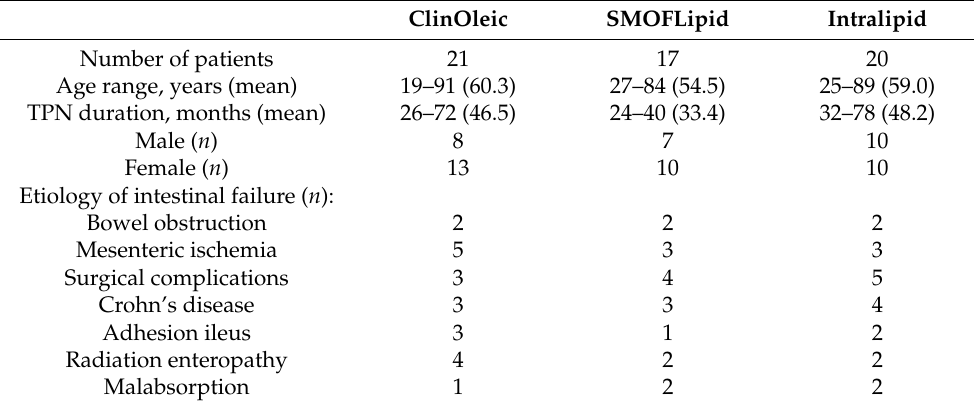
Table 1. Characteristics of the patients according to lipid emulsion